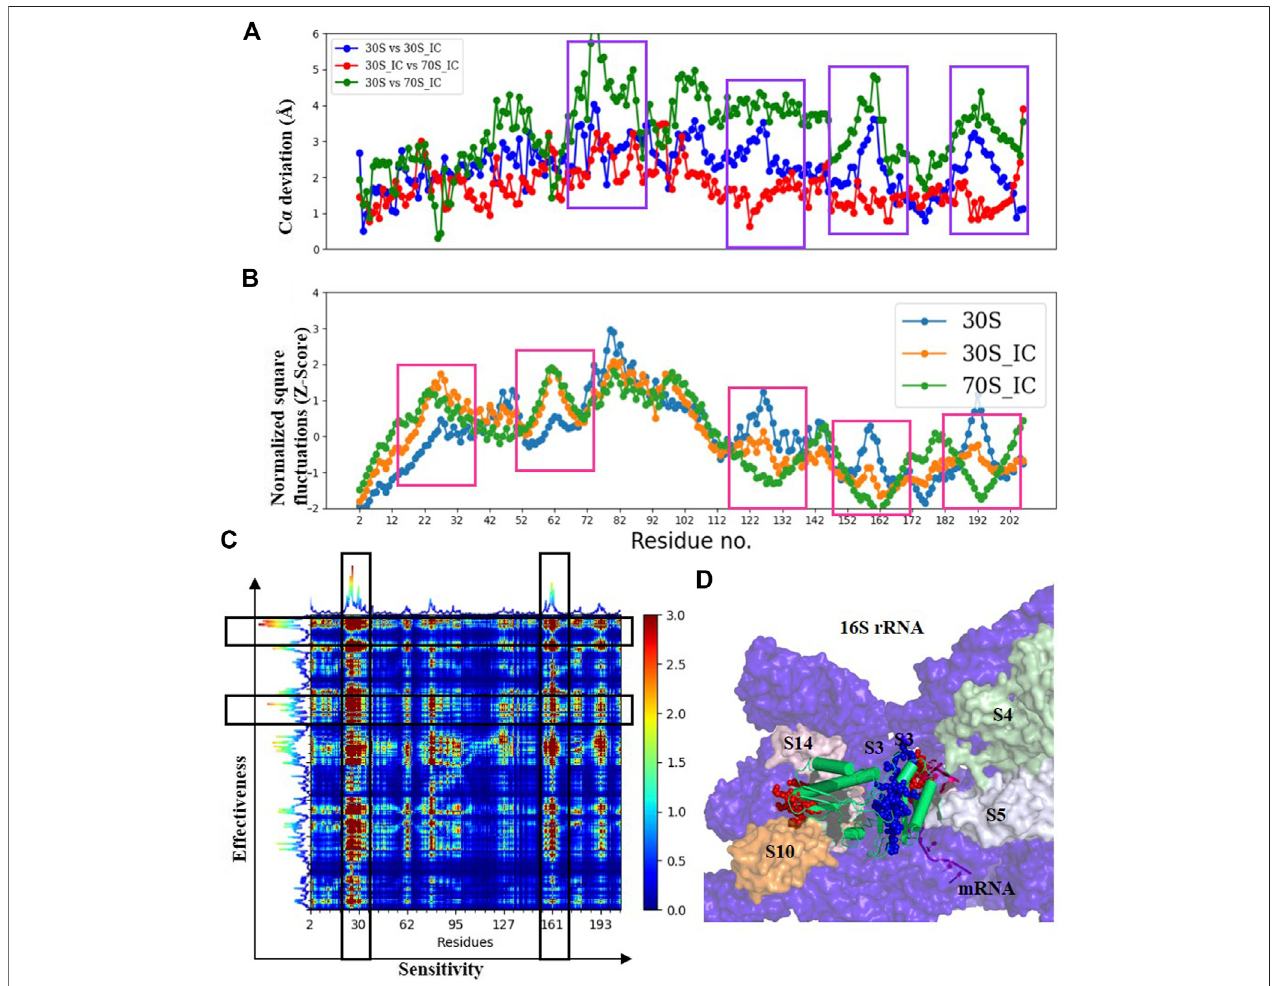
FIGURE 4 | Understanding the dynamics of S3 (A) C α -deviation plot for S3 in pair wise comparison of its deviation in all the complexes is shown in a scatter plot. Higherdeviationindicateshigherlocalstructuralvariabilityamongthosestructures.Theregionsdisplayinghigherlocalstructuraldifferenceshavebeenmarkedwithdark blue rectangles. (B) Scatter plot of normalized square fl uctuations of S3 from 30S, 30S_IC and 70S_IC (in the form of Z-Score). Residues with Z-Score values above 2 and below − 2 are considered to show higher fl exibility. The regions showing signi fi cant difference in fl exibility have been marked with red rectangles. (C) The PRS analysisoftheS3proteinshownasaheatmapwithsensitivitypro fi leontheX-axisandeffectivenesspro fi leontheY-axis.Regionsmarkedbyaverticalrectanglecontain most sensitive residues while horizontal rectangle depicts the most effective residues. (D) A region of the structural map of the 30S complex (4JIL) highlighting the S3 (yellow) interacting partners. S3 interacts with mRNA (light orange), S14 (blue), S10 (deep orange) and 16S rRNA (deep blue) in surface representation. The effectors (blue) and sensors (red) identi fi ed in S3 are represented as